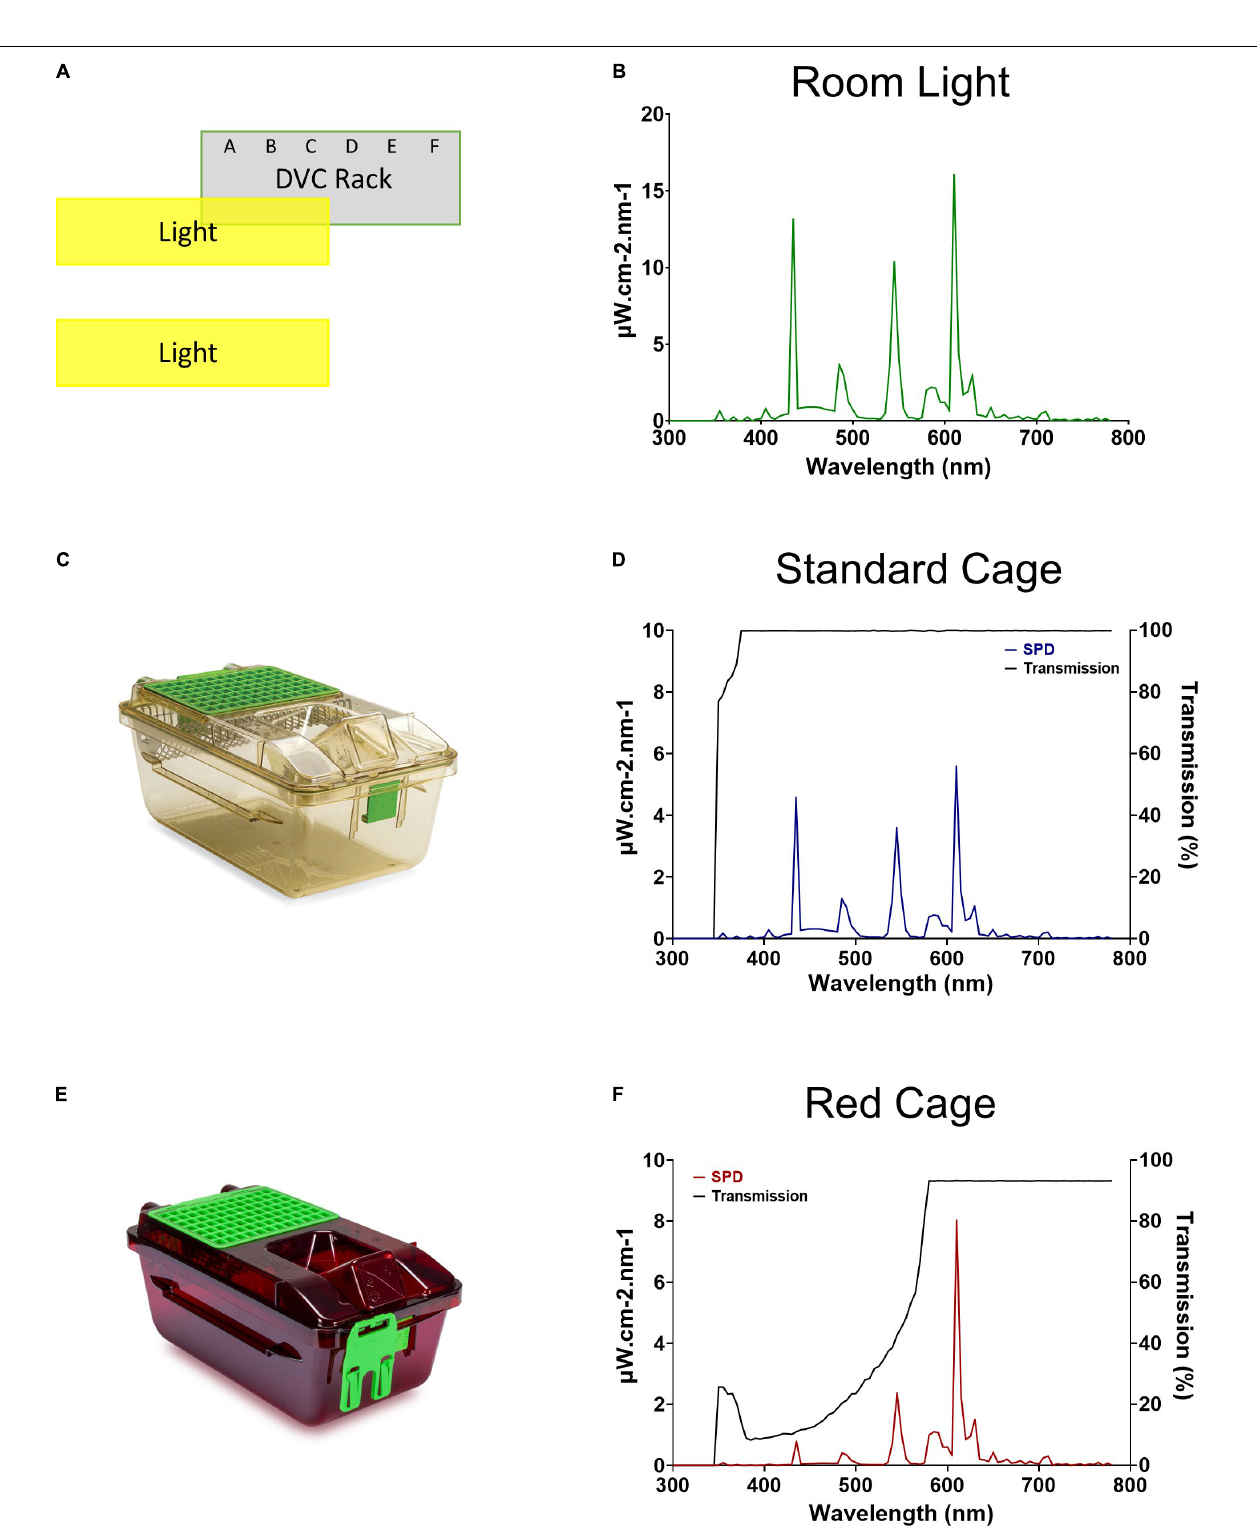
FIGURE 1 | Room lighting and cage transmission. (A) Schematic of the relative positioning of the DVC rack and the room lights. (B) Spectral power distribution of the DVC room light. (C) Standard Green Line individually ventilated cage (IVC; Tecniplast GM500). (D) Spectral power distribution of the internal light environment, and the transmission, of a standard cage. (E) Red individually ventilated cage (IVC; Tecniplast GM500). (F) Spectral power distribution of the internal light environment, and the transmission, of a red cage.